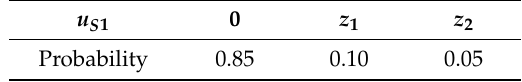
Table 3. Probability determination for particular states of S 2 network configuration.